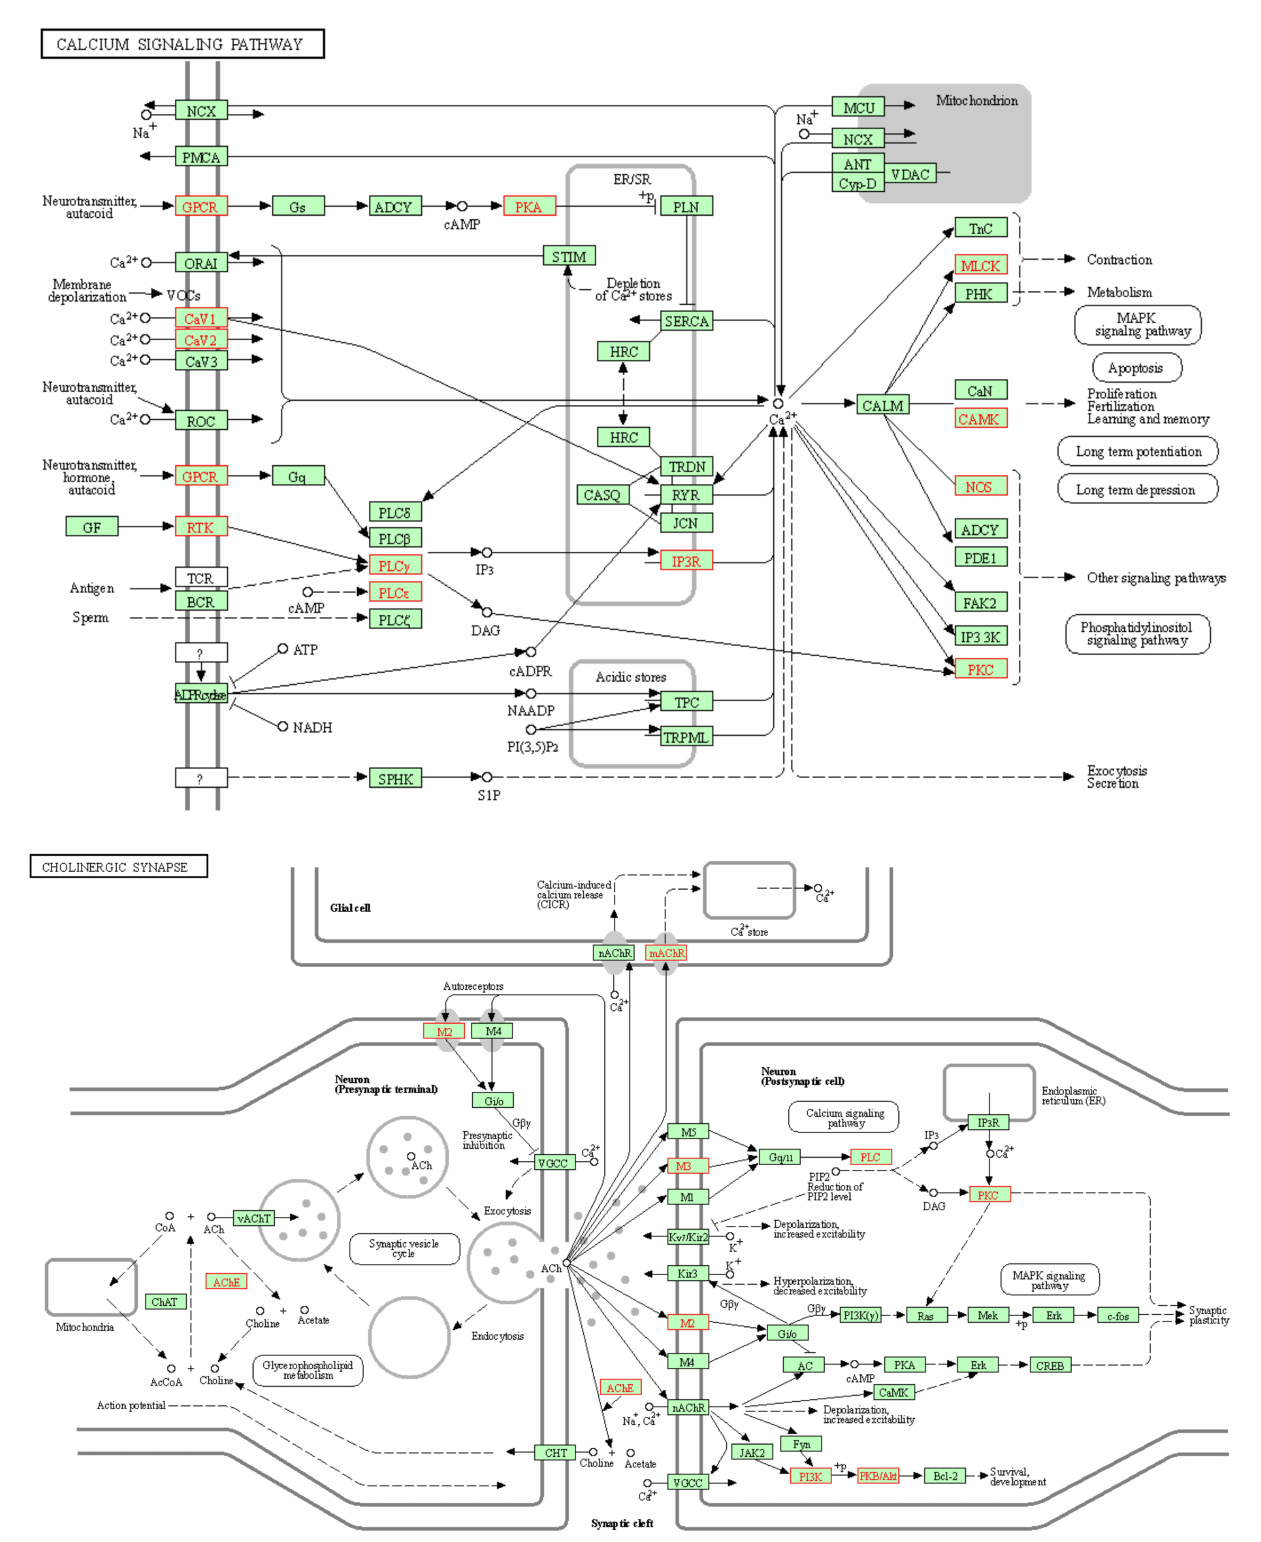
Figure 5. KEGG pathway for calcium mediates signaling and cholinergic synapse. The red boxes indicate the possible proteins targets of